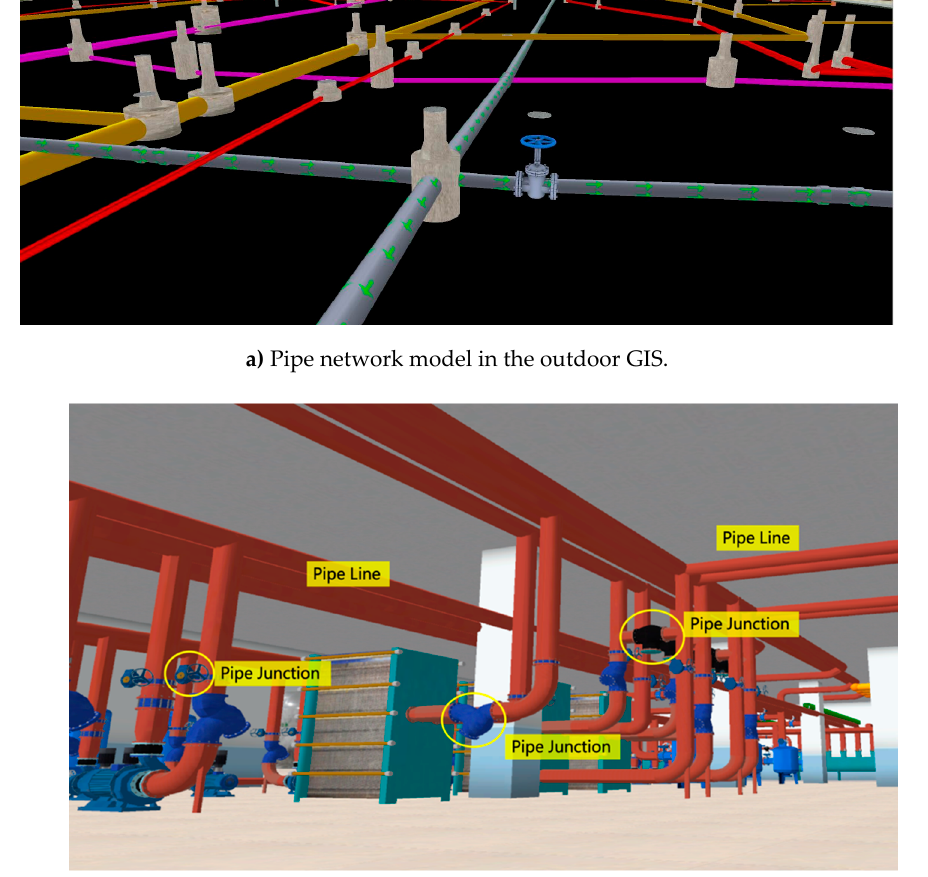
Figure 13. Pipeline network in the SuperMap iEarth.